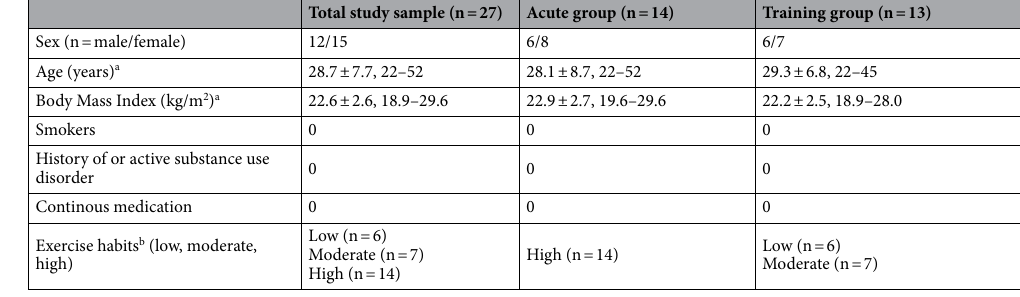
Table 1. Participant characteristics for the total study sample and by allocation to exercise program, i.e. the high-intensity and moderate-intensity exercise program. a Mean ± s.d., range. b Self-reported measure of recent exercise